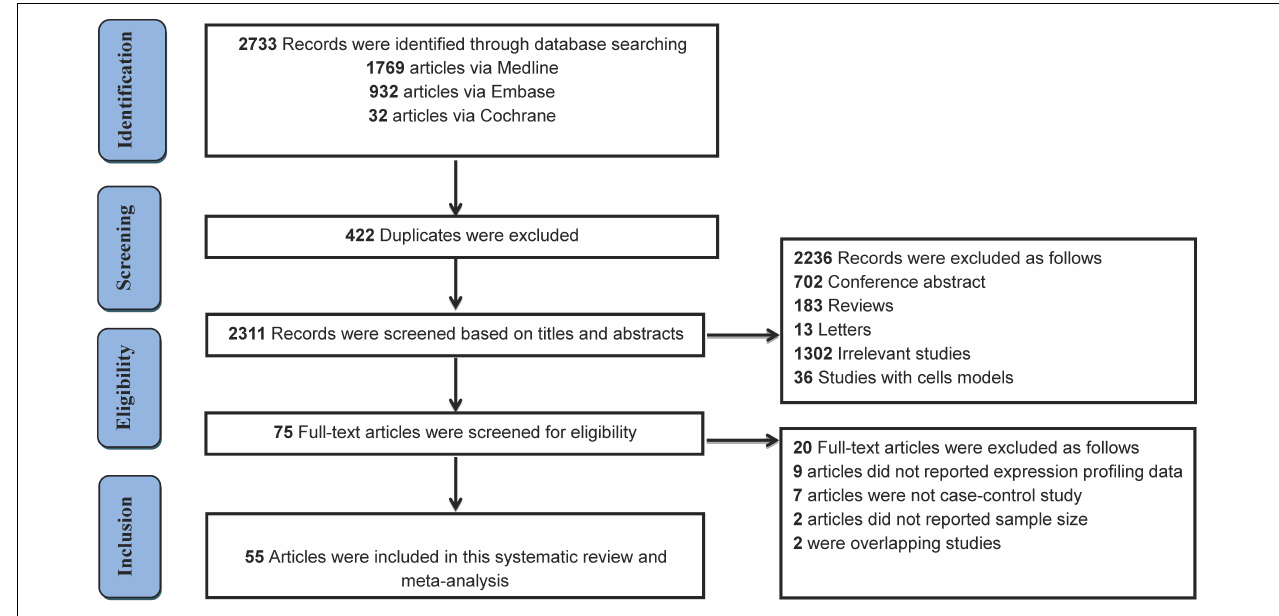
FIGURE 1 | Flow chart for the selection of eligible